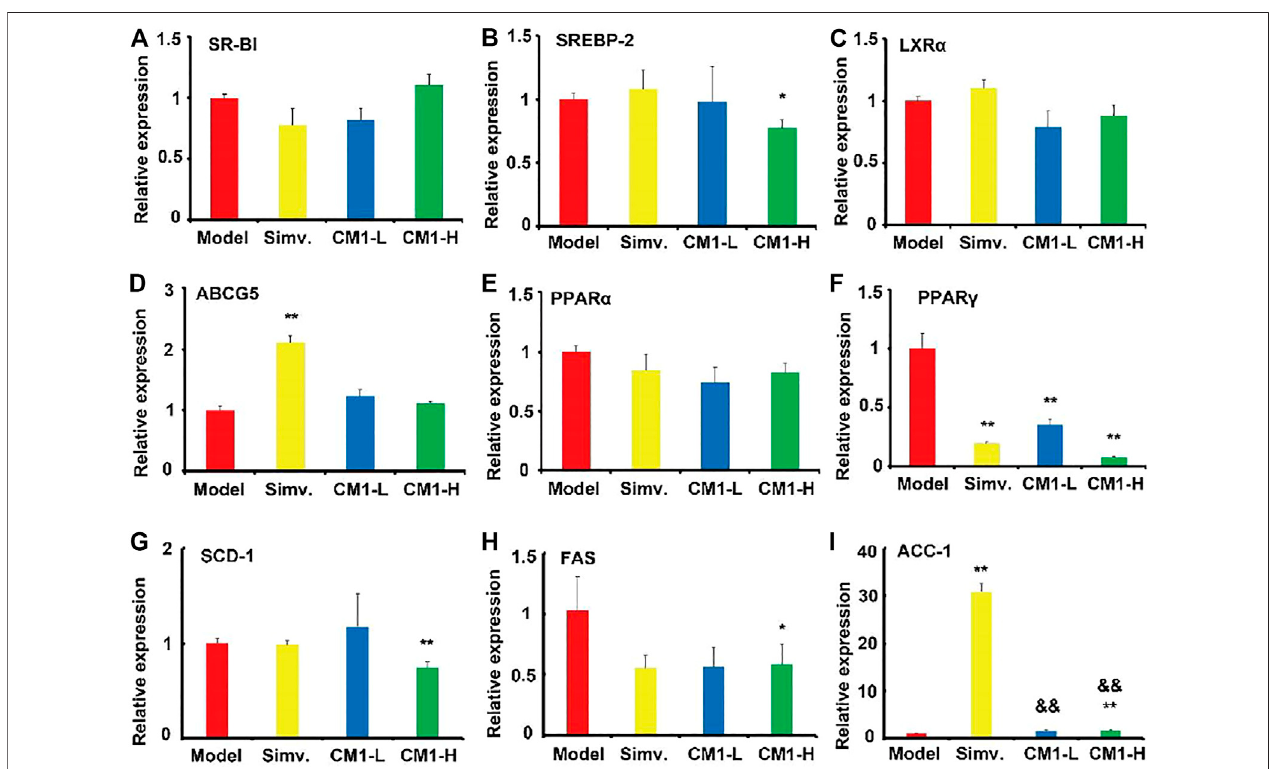
FIGURE 5 | Effect of CM1 on the mRNA expression of lipid metabolism related genes in the liver of the LDLR (-/-) mice ( n (cid:2) 3). (A) , SR-BI; (B) , SREBP-2; (C) , LXR α ; (D) ,ABCG5; (E) ,PPAR α ; (F) ,PPAR γ ; (G) ,SCD-1; (H) ,FAS; (I) ,ACC-1. *means p < 0.05 vs .Model, and**means p < 0.01 vs .Model; && means p < 0.01 vs .Simvastatin.